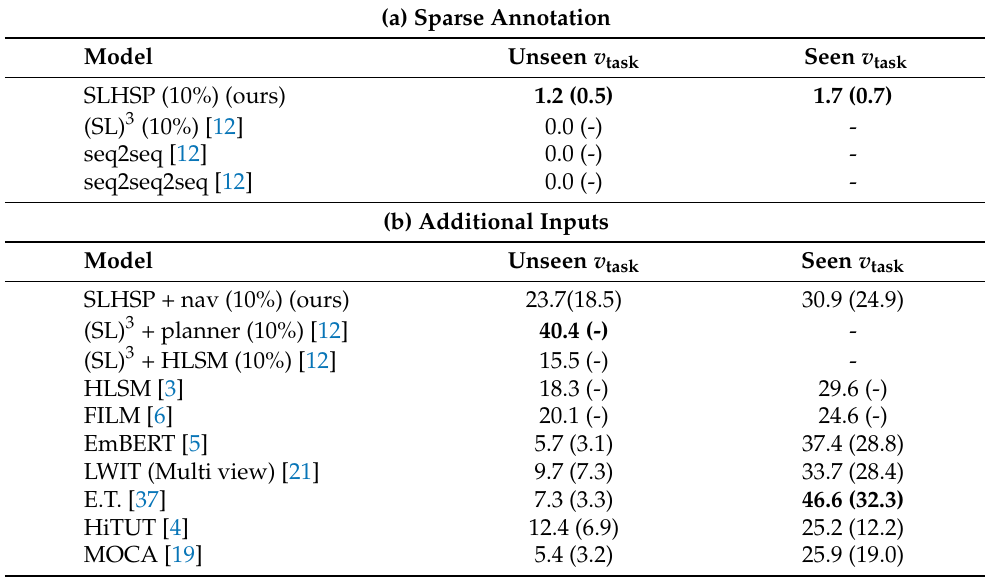
Table 2. Task success rate v task evaluation on ALFRED benchmark for models trained with sparse annotations and additional inputs, reported for seen and unseen folds. Values in parentheses are PLW success rates p × v task , and boldface indicates highest in column. “-” denotes unreported scores. (a) Sparse Annotation